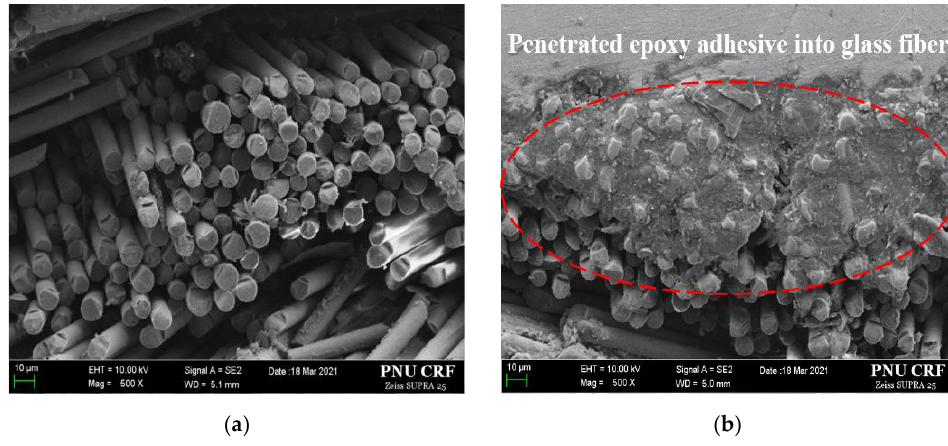
Figure 12. SEM images of the fracture surface of tensile test specimens: ( a ) surface of glass fibers in nonadhesive-treated FSB; ( b ) epoxy adhesive-penetrated glass fibers of FSB.